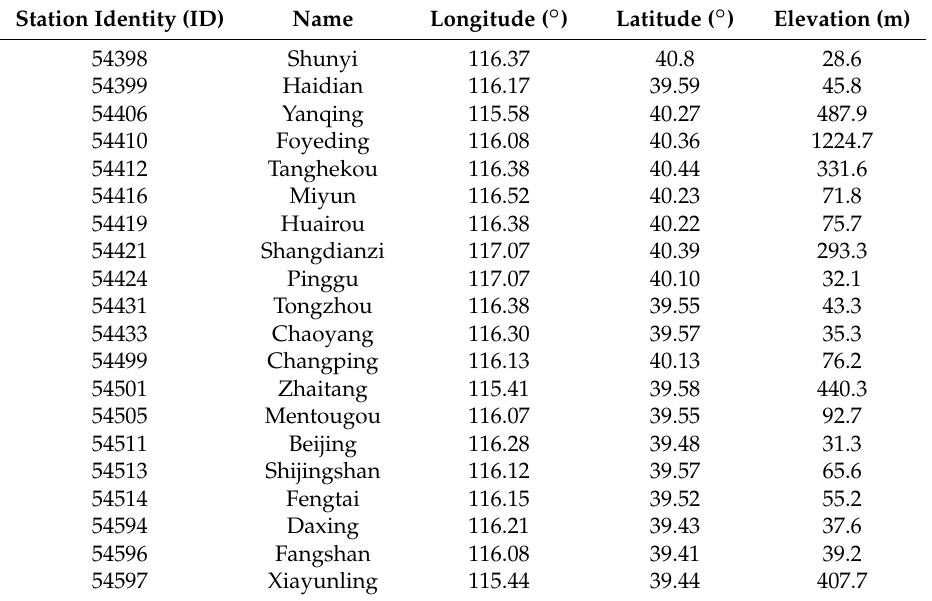
Table 1. Information on stations and their locations used in the study.